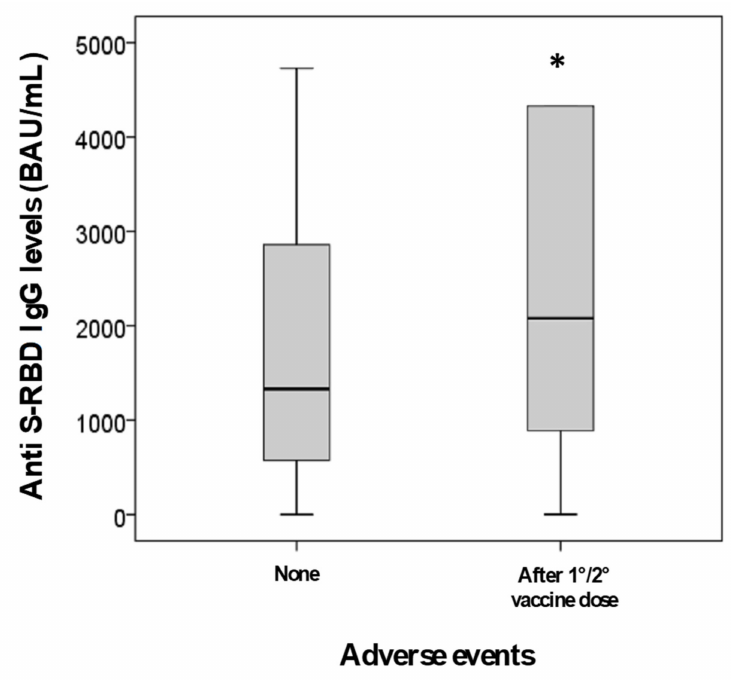
Figure 4. Anti S-RBD IgG levels in subjects sub-grouped by the absence or the presence of symptoms after first and/or second dose (* p = 0.001 vs. absence of symptoms).